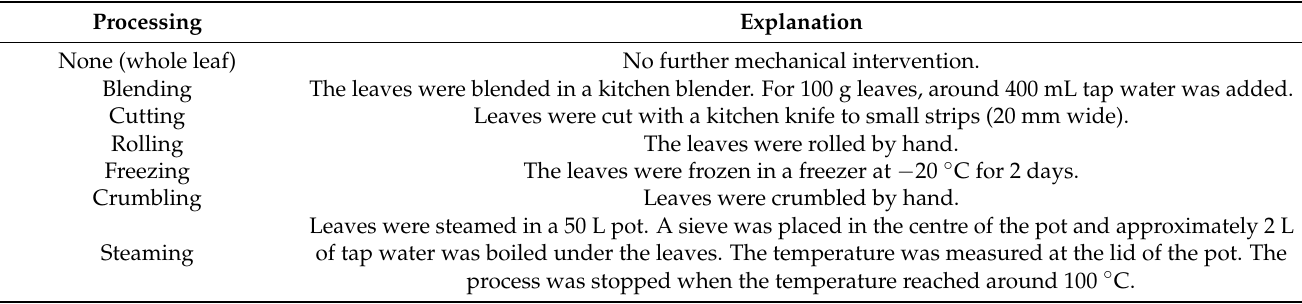
Table 2. Processing steps and their explanation.